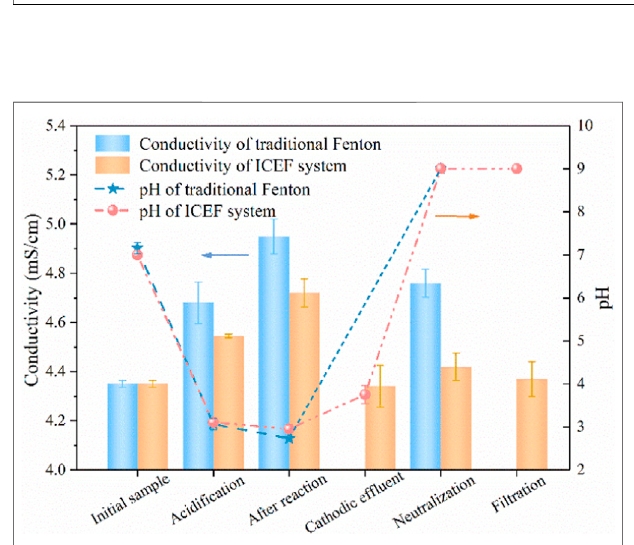
FIGURE 8 | Concentration variations of conductivity and pH under different conditions. (PNP (cid:1) 100 mg/L, Na 2 SO 4 (cid:1) 3 g/L).